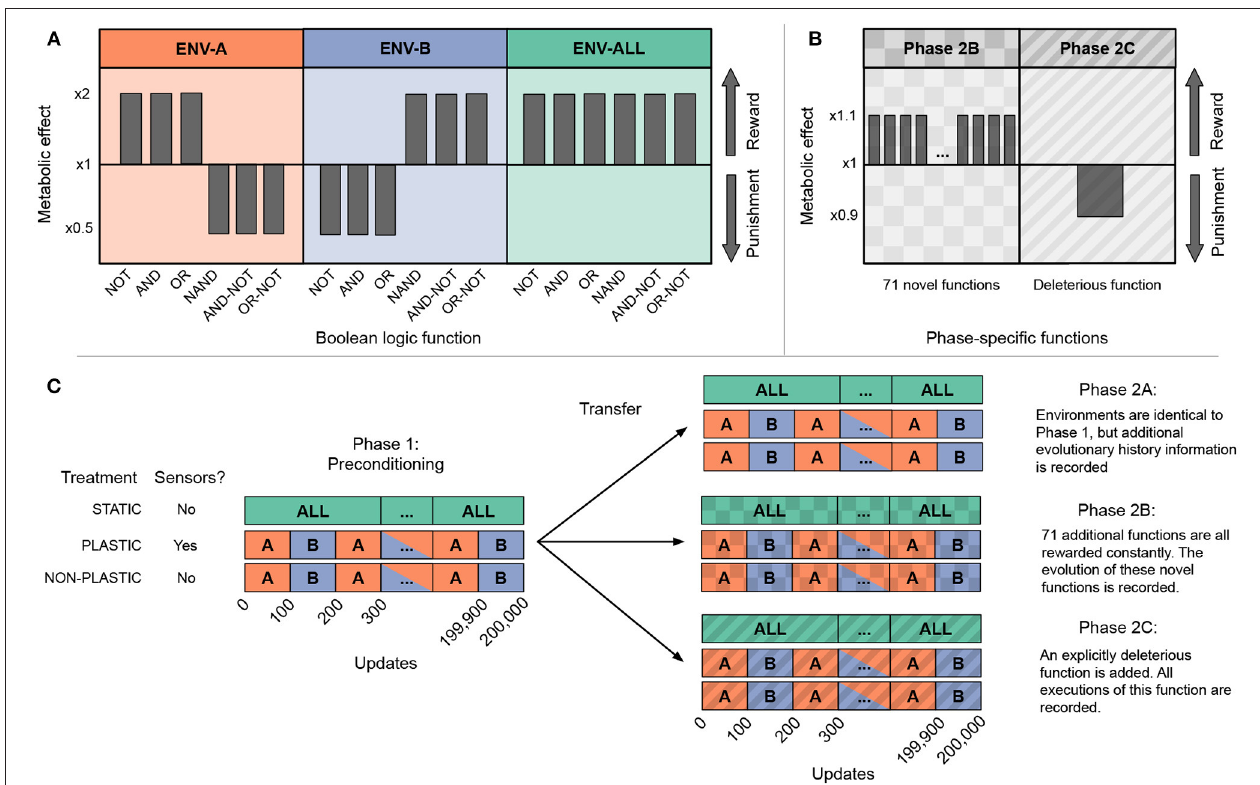
FIGURE 2 | Overview of experimental design. The three plots in (A) show the environmental conditions used in every experiment and whether they reward or punish each base function. The two plots in (B) show the additional functions added in phases 2B and 2C. (C) Shows treatment differences and experimental phases. Treatments are listed on the left, with each treatment specifying its environmental configuration and whether sensors are functional. We conducted three independent two-phase experiments, each described on the right. Phases 2B and 2C are textured to match their function definitions in (B) . Phase one is repeated for each experiment with 100 replicate populations per treatment per experiment. For each replicate at the end of phase one, we used an organism of the most abundant genotype to found the second phase population. All STATIC and NON-PLASTIC populations move on to phase two, but PLASTIC populations only continue to the second phase if their most abundant genotype exhibits optimal plasticity. Metrics are recorded only in phase